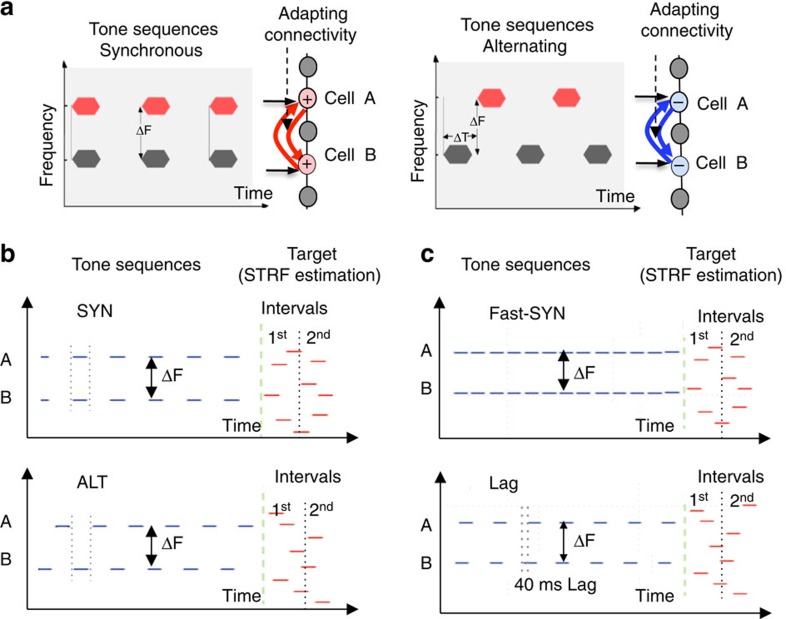
Experiment design and the temporal coherence principle.(a) Rationale for the design of the experiments. Synchronous and alternating tones are perceived differently even when the tones are well separated in frequency: the former are perceived as one source, while the latter are perceptually segregated into separate streams. It is hypothesized that the two types of tone sequences induce differential rapid changes in connectivity among the neurons they drive. We conjecture that when coherently driven by synchronous tones, neurons (cell A and cell B) tuned to the two frequencies rapidly form mutually excitatory (cooperative) connections (red arrows). However, when they are driven by alternating tones, we predict that neurons rapidly form mutually suppressive (competitive) connectivity (blue arrows). It is further hypothesized that engagement of attention is necessary to induce these changes in functional connectivity. (b) Experimental stimuli. A trial consisted of synchronous (SYN) or alternating (ALT) sequences of 100 ms tones that were followed by a cloud of random tone pips. The frequency of the B tone was fixed at or near most of the CFs of simultaneously recorded neurons in a given experimental neurophysiological recording session. The frequency of A tones changed randomly from one trial to another to be 24, 12, 6 or 3 semitones above or below the B tone. Animals were required to withhold licking during tone sequences and to respond by licking the waterspout following the onset of the random tones (Target). Responses to these random tones in the target tone cloud were used to measure the STRFs of the recorded neurons. (c) Experimental stimuli for fast-SYN and Lag. Stimuli for two control conditions: Fast-SYN consisted of the same stimuli as SYN, except that the rate of tone presentation was doubled to match the rate of the tones in the ALT condition. In the Lag stimulus, there was a 40ms time-lag between the tones in the A and B streams.